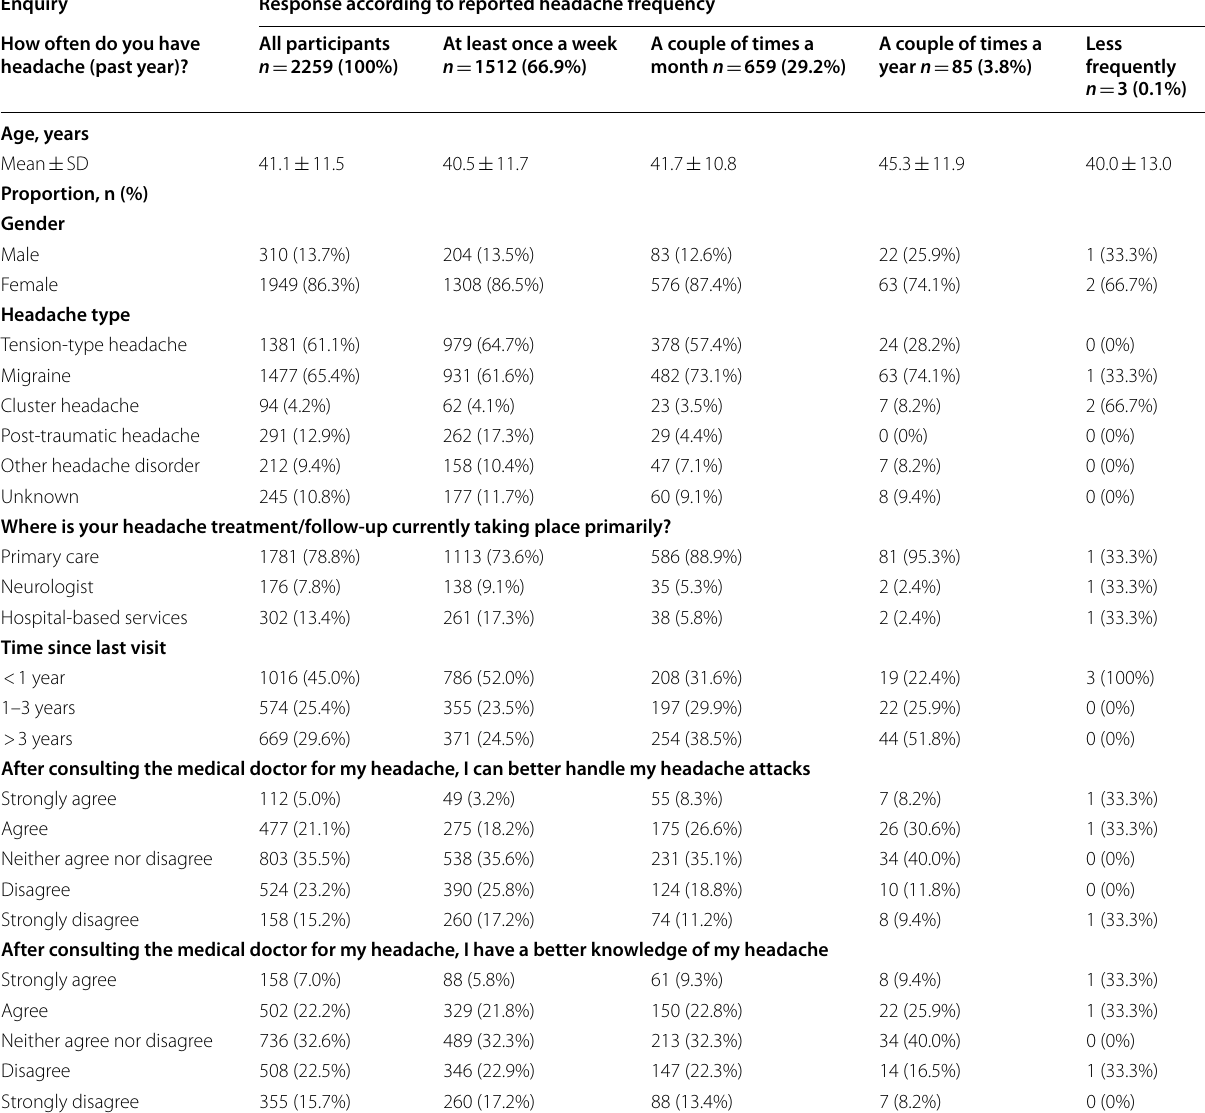
Table 7 Perceived quality of care of participants who had sought medical advice Enquiry Response according to reported headache frequency How often do you have headache (past